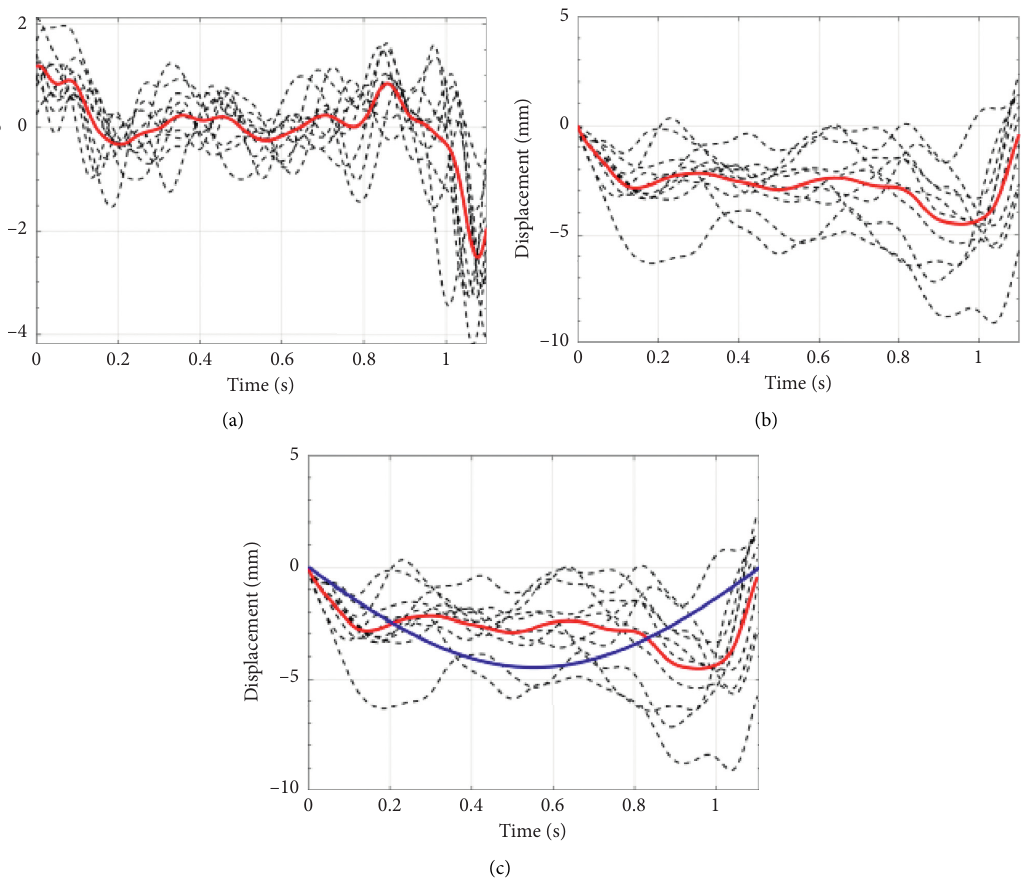
Figure 8: (a) Superposition of the acceleration time-histories associated with each span of the Le Grotte viaduct (the solid lines represent the average curve). (b) Superposition of the displacement time-histories associated with each span of the Le Grotte viaduct (the solid lines represent the average curve). (c) is the figure in (b) with the blue line representing the optimum theoretical